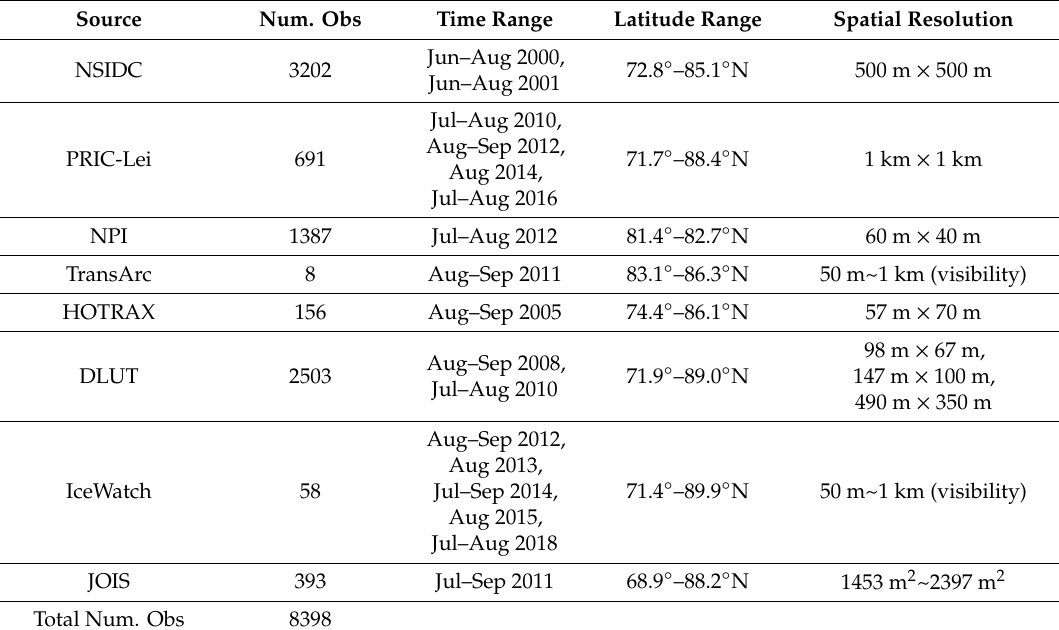
Figure 1. The geographical distribution of the observed MPF from multiple sources. The base map was developed by Esri using HERE data, Garmin basemap layers, OpenStreetMap contributors, Esri basemap data, and data from the GIS user community. Table 1. Information of MPF observations used in network training.